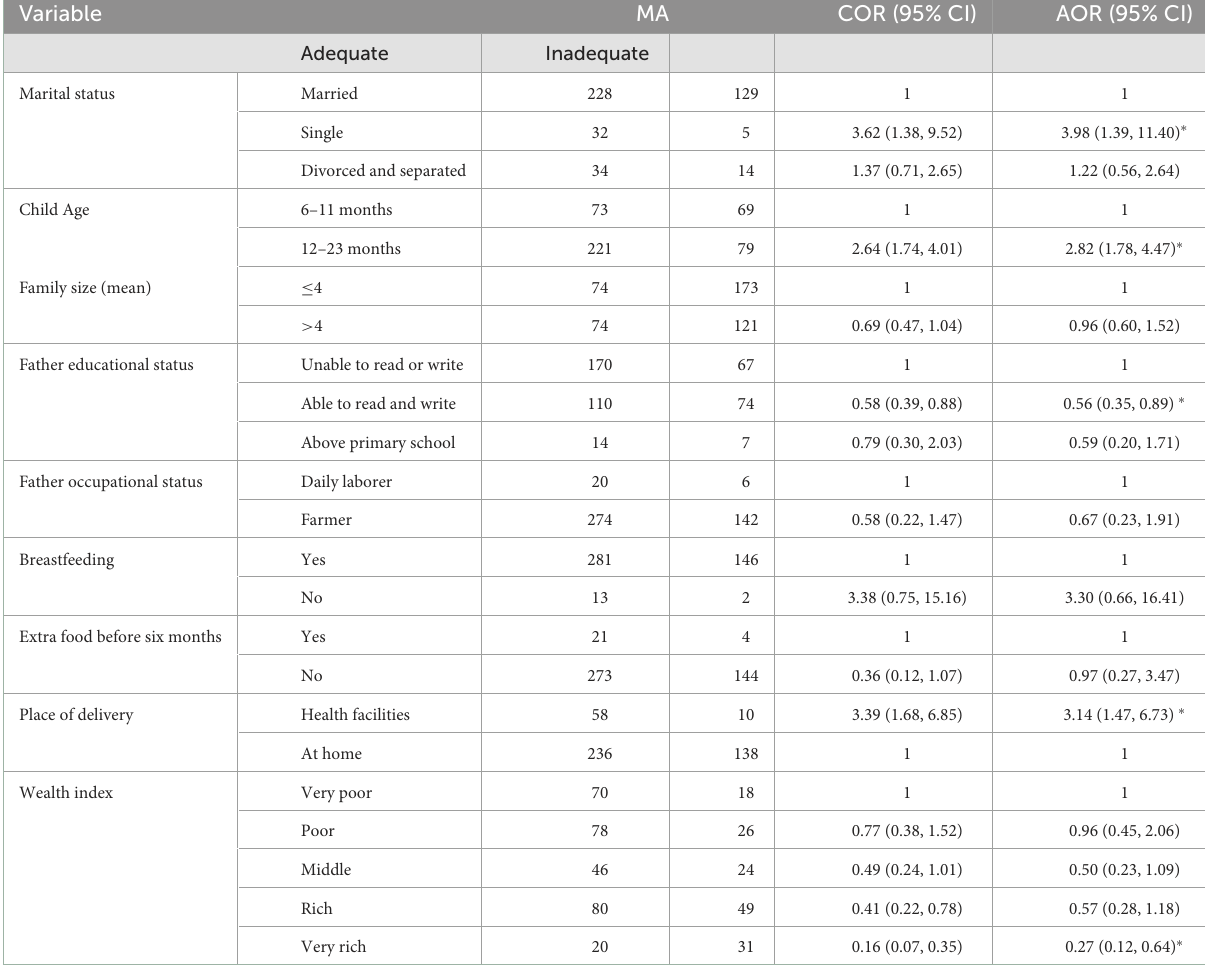
TABLE 5 Factors associated with MAD uptake among infants aged 6–23 months in South Gondar Zone, Northwest Ethiopia, 2017 ( n = 442).